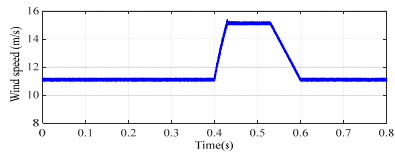
Figure 6. Gust wind speed curve.